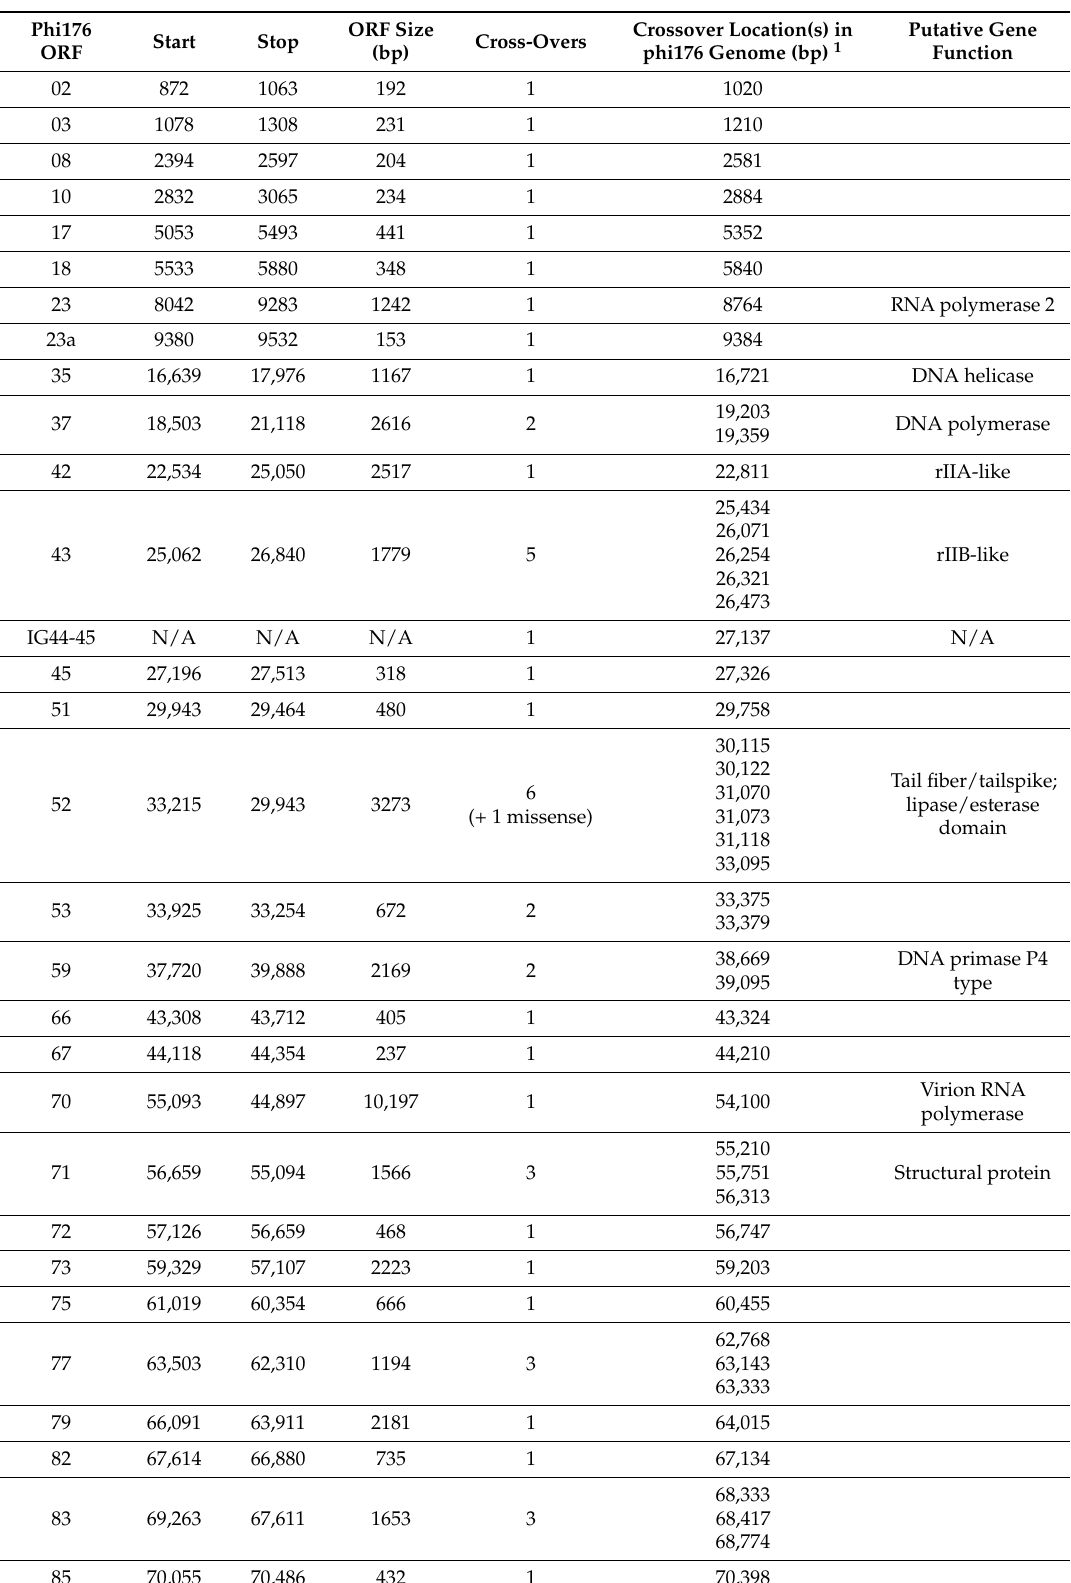
Table 5. Recombinant phi176